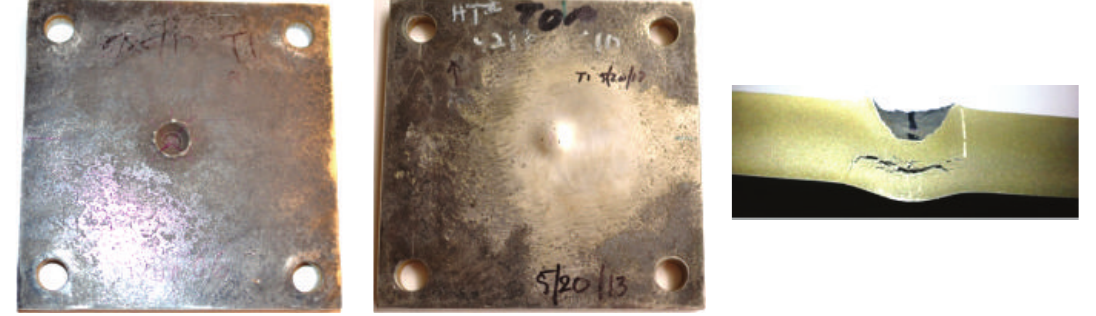
Figure 5: Typical target plate after an